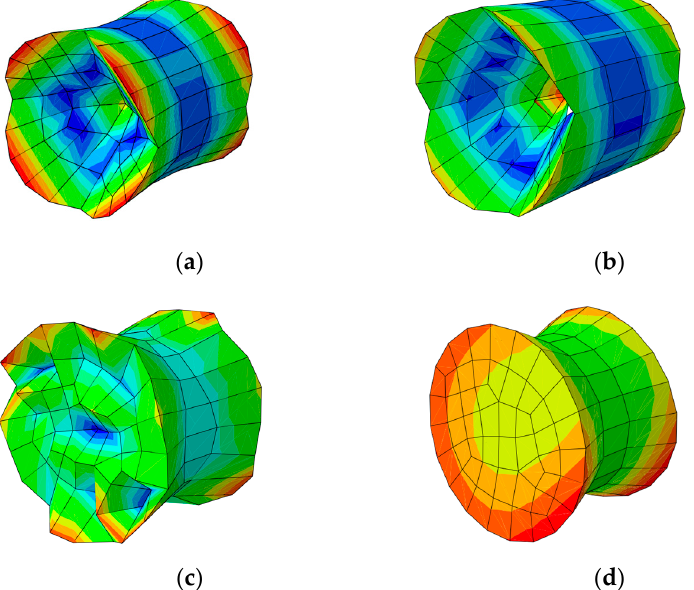
Figure 8. Shape of the support pillar deformation for the following mesh sizes: ( a ) 5.0 mm; ( b ) 1.0 mm; ( c ) 1.0 mm (0.1 mm near the support pillars); and ( d ) 5.0 mm (0.5 mm near the support pil- lars). Determined natural frequencies are 5941.5, 6752.4, 7584.3 and 7634.6 Hz, respec- tively. The finer the glass pane mesh in the vicinity of the contact surfaces is, the greater the natural frequencies in those cases are. Comparing the obtained results, creating one tiny finite element under the support pillar is the most effective solution (Figure 7d), which leads to the accurate numerical re- sult and reduces computational costs comparing to assumptions made in Figure 7c. This approach was assumed for the purpose of the further investigation.